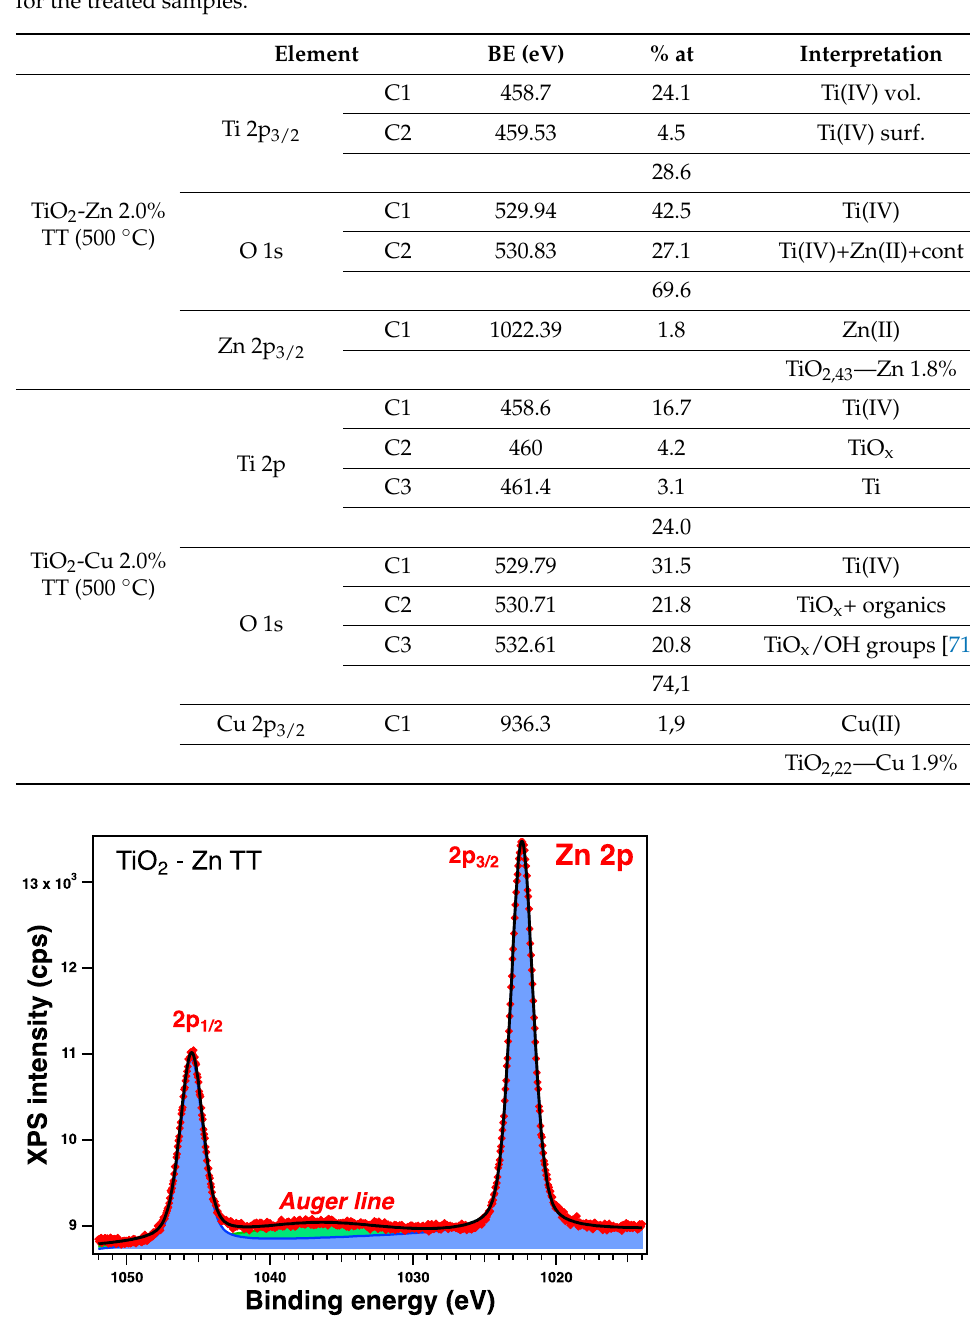
Table 5. Binding energies (BE), atomic %, and attributions of the deconvolutions for the core levels for the treated samples.